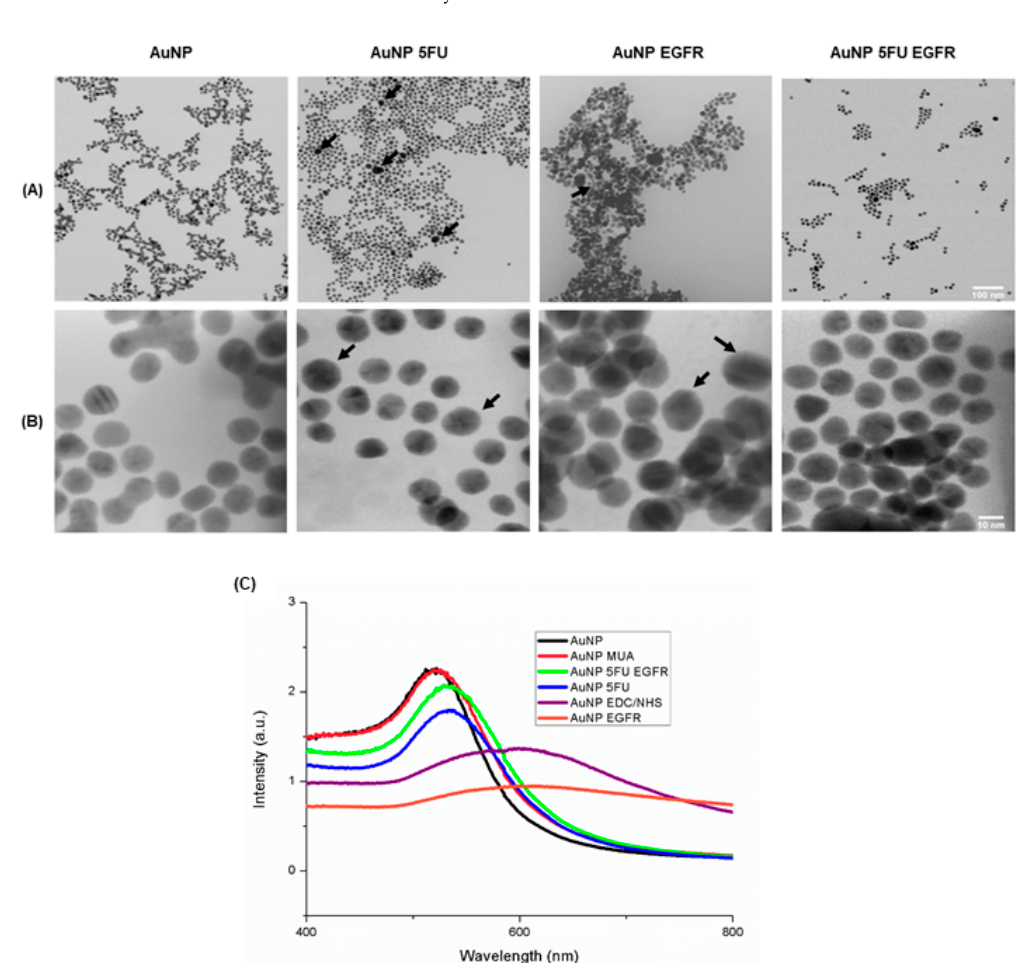
Figure 1. Physicochemical characterization of AuNP and constructs by transmission electron microscopy (TEM) of AuNP. The scales are in the sizes of ( A ) 100 nm and ( B ) 10 nm, respectively of AuNP; AuNP 5FU; AuNP EGFR and AuNP 5FU EGFR. ( C ) UV-vis spectra: on black line AuNP without modification; on pink line, modified with MUA; on green line modified with 5FU EGFR; on blue line AuNP 5FU; on purple line EDC/NHS and on orange line EGFR.